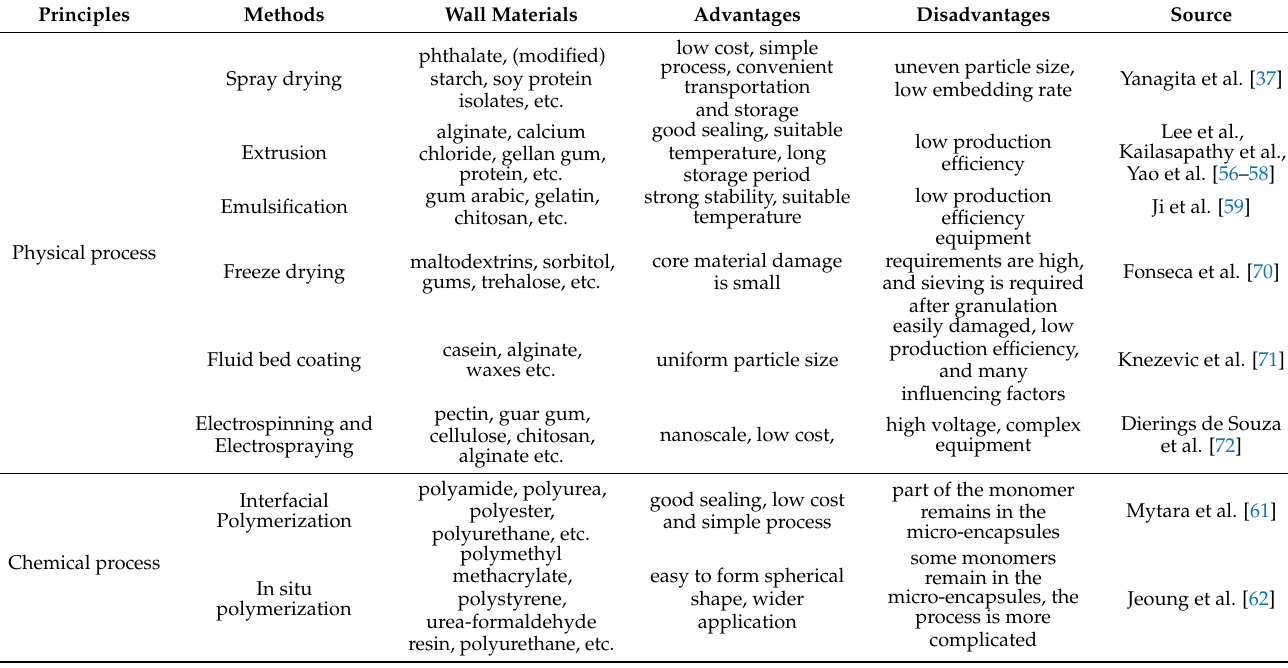
Table 2. Principles, methods, wall materials, advantages and disadvantages of micro-encapsulation